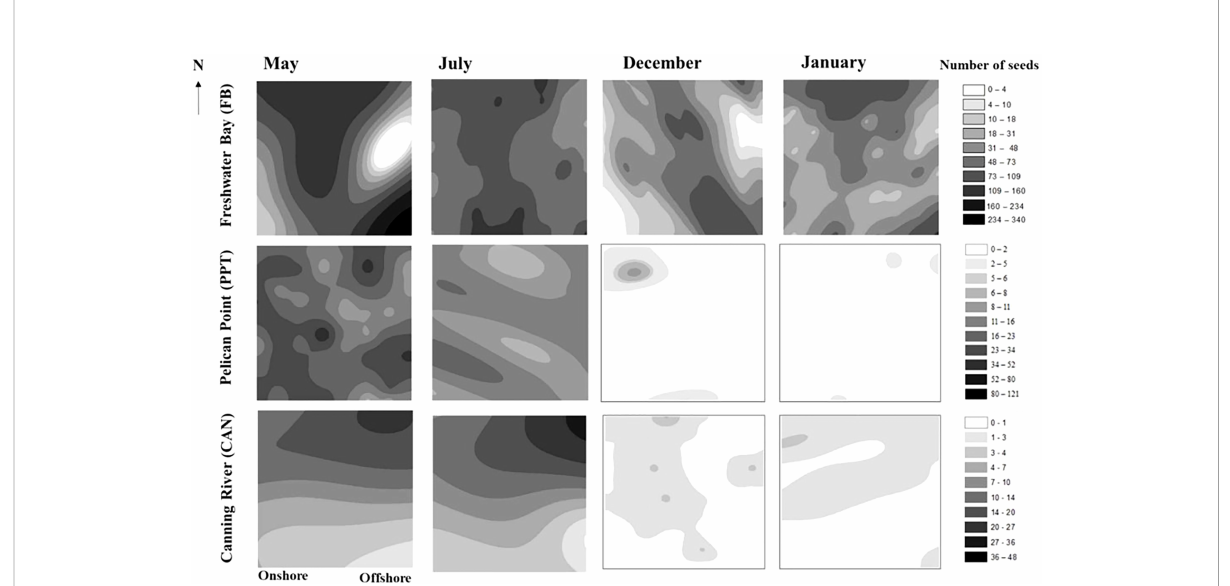
FIGURE 4 Halophila ovalis seed bank spatial distribution of FB, PPT, and CAN over an annual reproductive cycle. The legend on the right side explains the number of seeds at each of the sites. The permanent plot has a size of 16×16 m 2